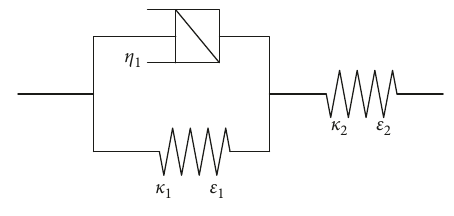
Figure 1: Generalized Kelvin